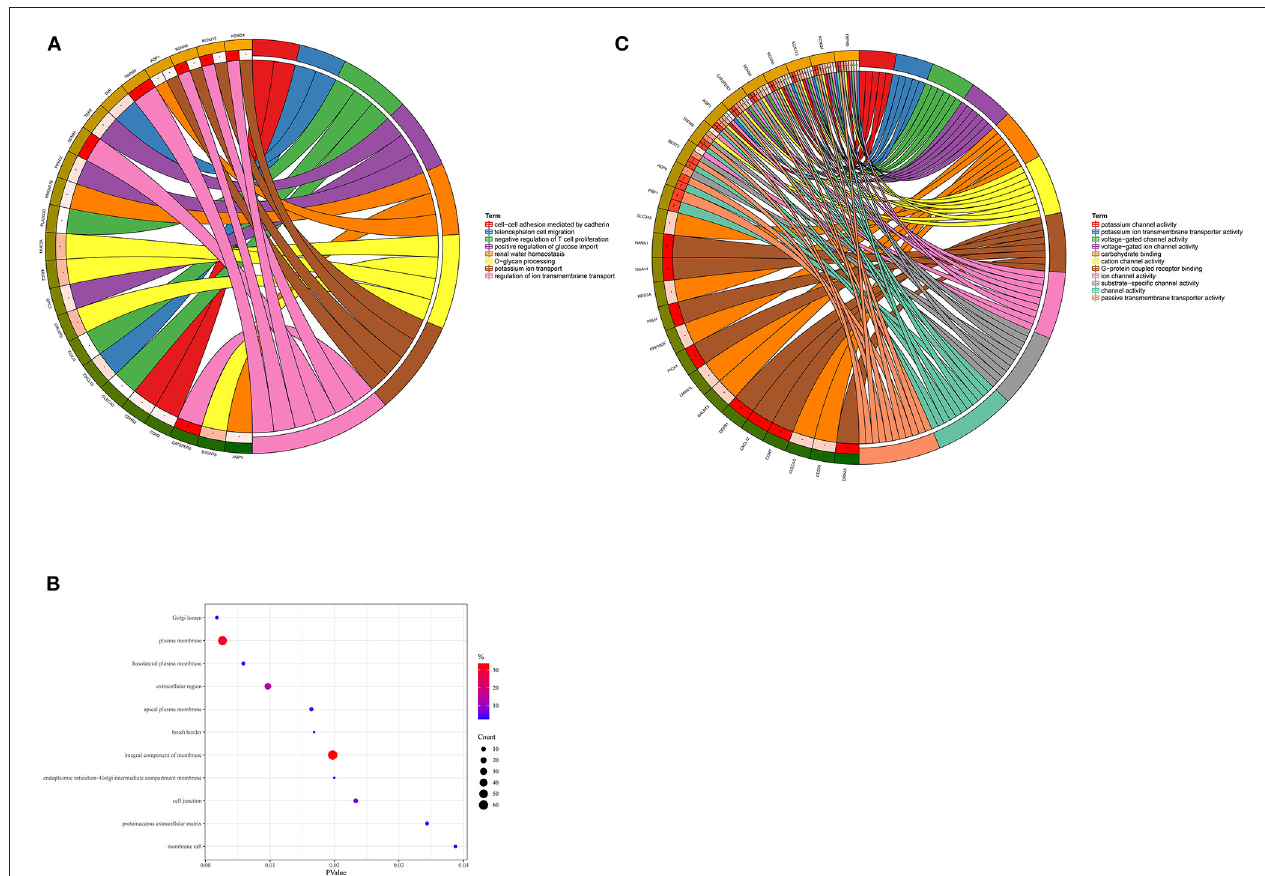
FIGURE 3 | Gene Ontology enrichment analysis. (A) Biological process. (B) Cellular component. (C) Molecular